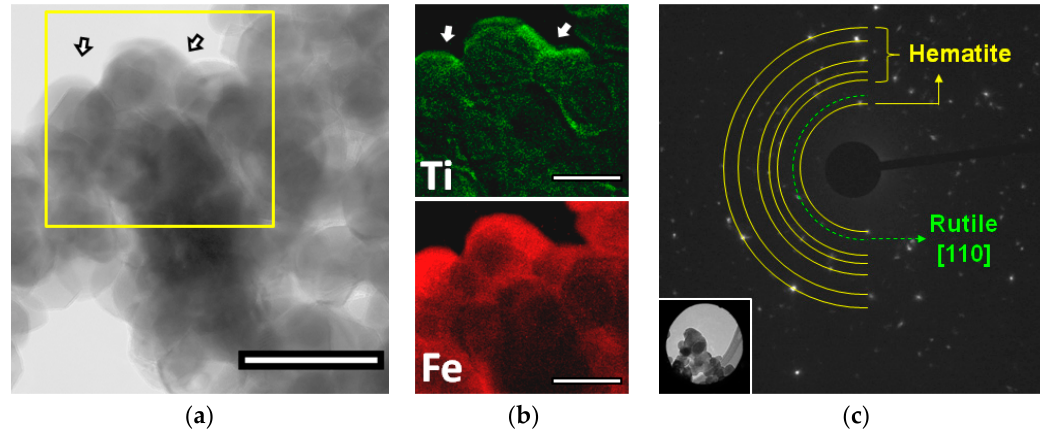
Figure 4. High resolution TEM and SAED imaging. ( a ) TEM micrograph of 10% Ti-modified hematite sample (100 nm scale bar); ( b ) related ESI elemental distribution maps for Ti and Fe (50 nm scale bars); ( c ) Electron diffraction analysis of selected area (in the figure inset below) of 10% Ti-modified hematite sample. The arrows indicate the SAED sampling zones.